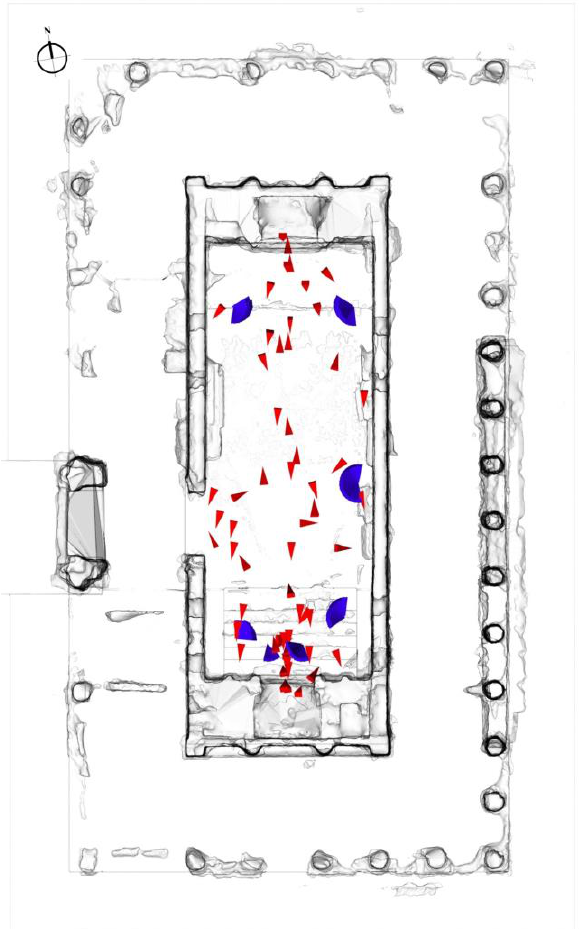
Figure 3: Interior photo network with camera stations and viewing directions in the final model plan (tourist photos in red; panoramas with their fields of view in